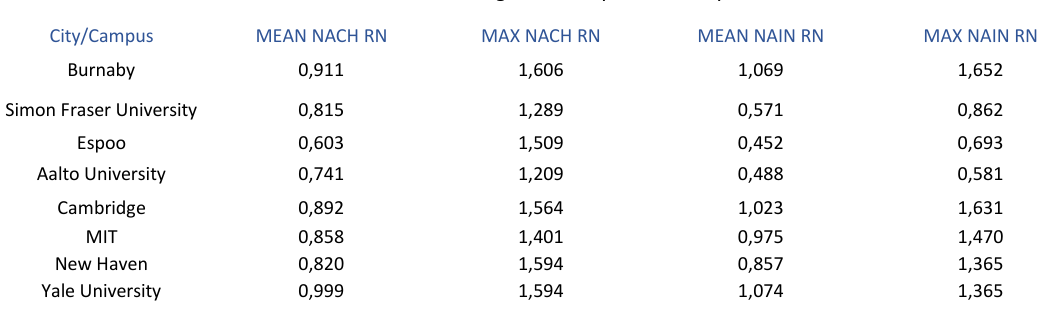
Table 3 Segment Analysis